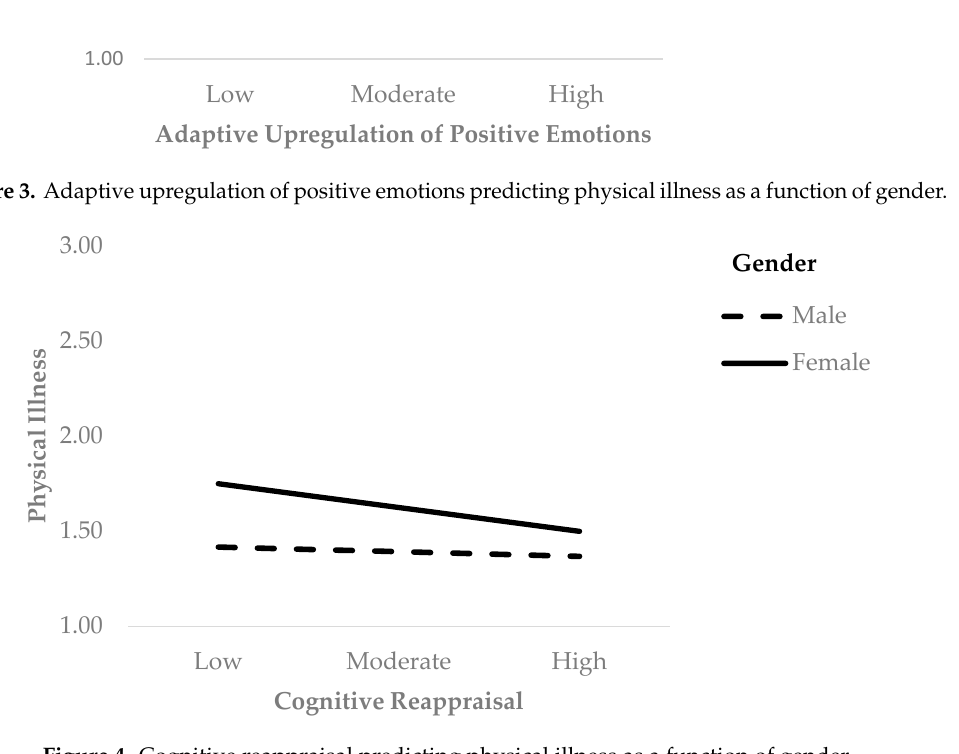
Figure 5. Maladaptive downregulation of positive emotions predicting burnout as a function of gender.